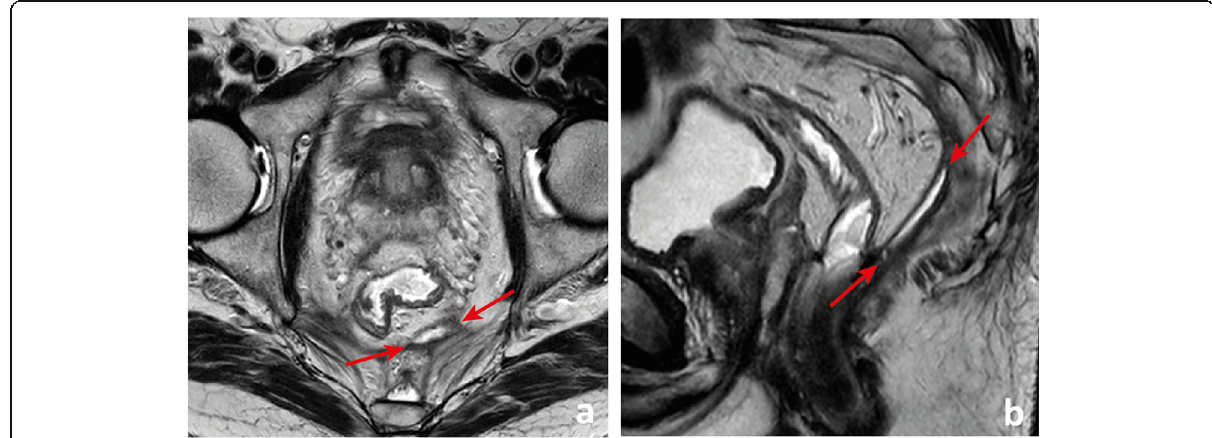
Fig. 8 Patient who underwent low anterior resection for rectal cancer presented with a posterior colorectal anastomotic leak which became a chronic fluid collection (between arrows in a and b )